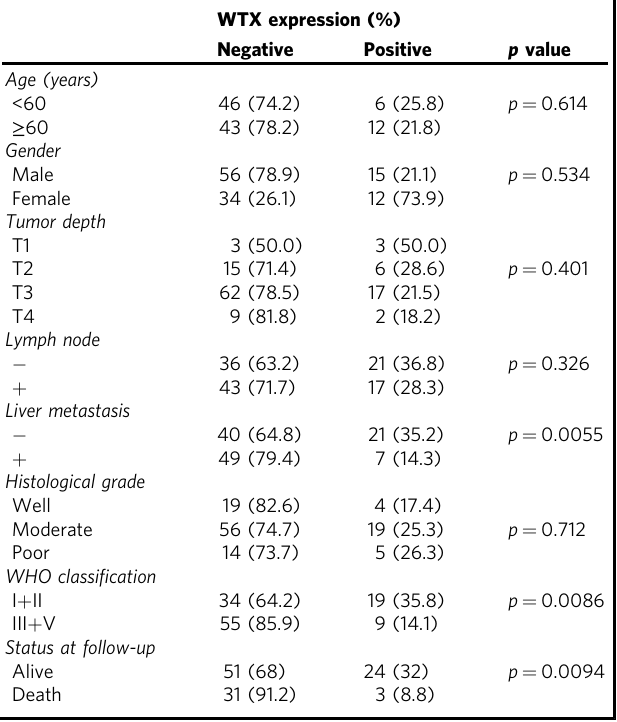
Table 1 The correlation of WTX expression with the clinicopathological features of